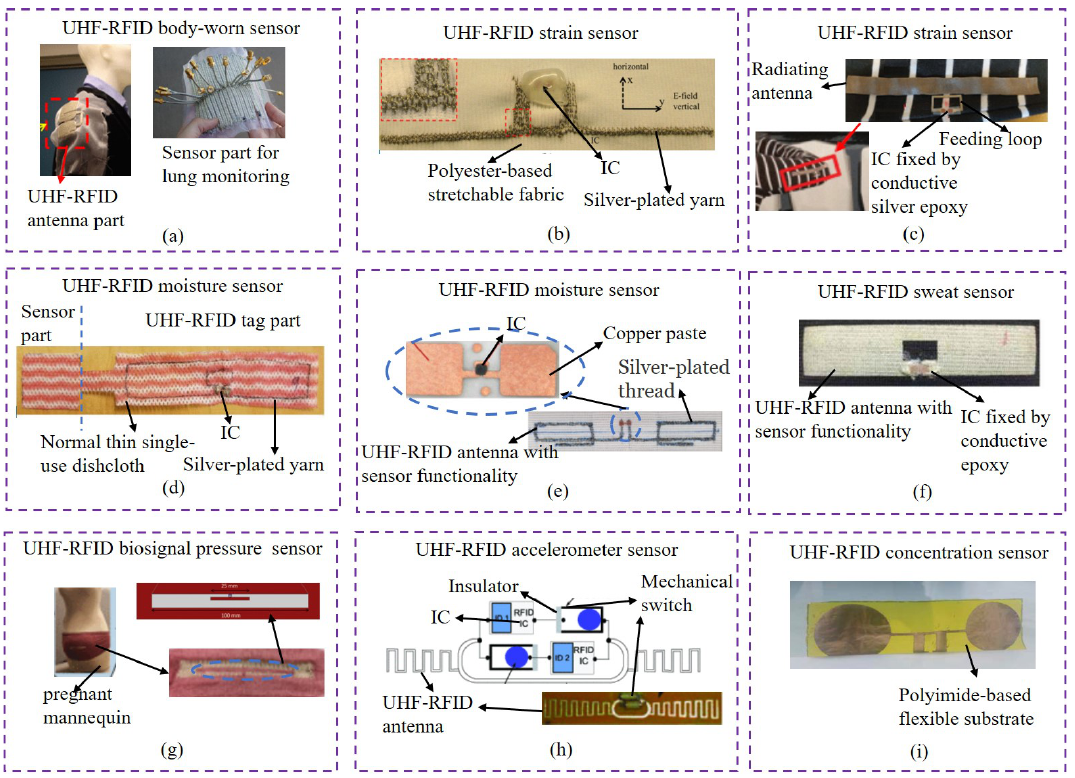
Figure 7. Typical textile UHF-RFID sensor applications. ( a ) Medical-based UHF-RFID body-worn sensor for lung monitoring integrated as part of the garment, with real representation of antenna and sensing array configuration (adapted from ref. [67]); ( b ) deformation-monitoring-based UHF-RFID strain sensor for structural health monitoring applications, with dual-interrogation mode consisting of read range extraction mode and RCS-based sensing mode (adapted from ref. [68] ); ( c ) exercise-based textile UHF-RFID strain sensor for movement monitoring attached on a cotton-based shirt, with a non-stretchable feeding loop and a stretchable radiating antenna (adapted from ref. [69]); ( d ) environment-based textile UHF-RFID moisture sensor for humility detection, with a sensor part and an antenna part (adapted from ref. [65]); ( e ) environment-based textile UHF-RFID moisture sensor for environment humility detection, with a humility sensitive UHF-RFID antenna (adapted from ref. [70]); ( f ) health-care-based textile UHF-RFID sweat sensor for sweat rate measurements, with a tag as the sensing part made by screen printing technique (adapted from ref. [6]); ( g ) health-care-based textile UHF-RFID biosignal pressure sensors for infant heart monitoring, integrated with a modular software framework for interrogation, data storage and post-processing [7,8]); ( h ) health-care-based textile UHF-RFID accelerometer sensor for alerting on hospitalized patient bed exits with a superlow resolution (adapted from ref. [9]); ( i ) textile UHF-RFID concentration sensor for concentration detection using a sensing antenna (adapted from ref.